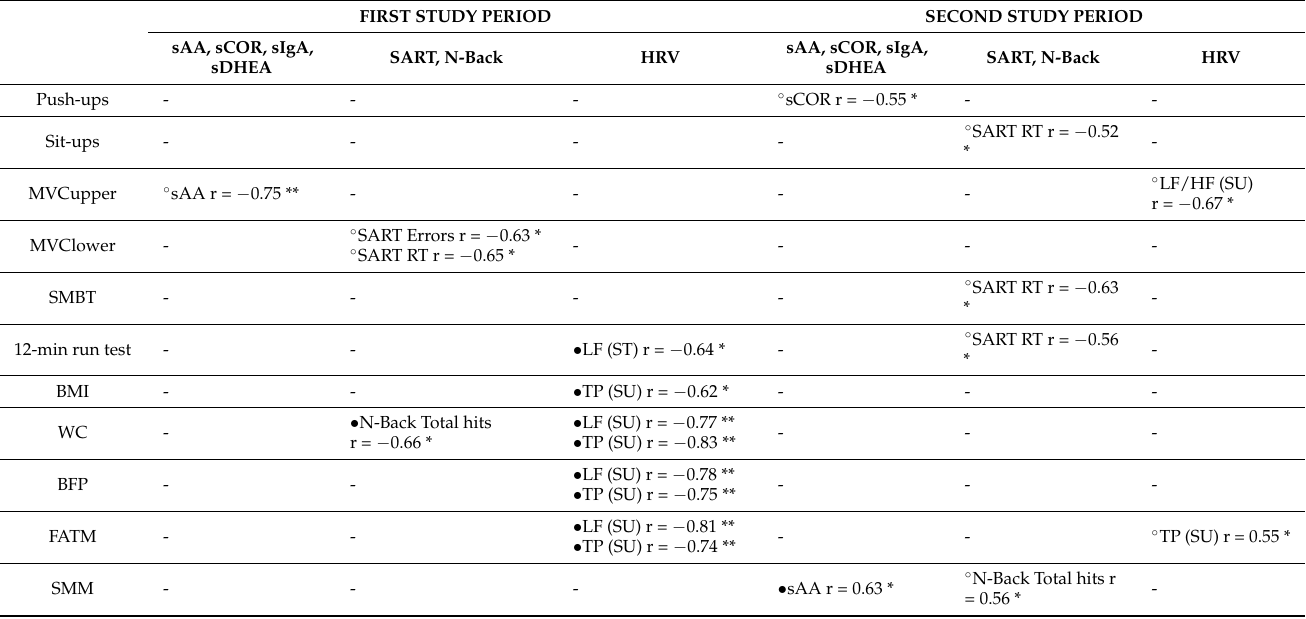
Table 3. Statistically significant correlations regarding physical fitness and body